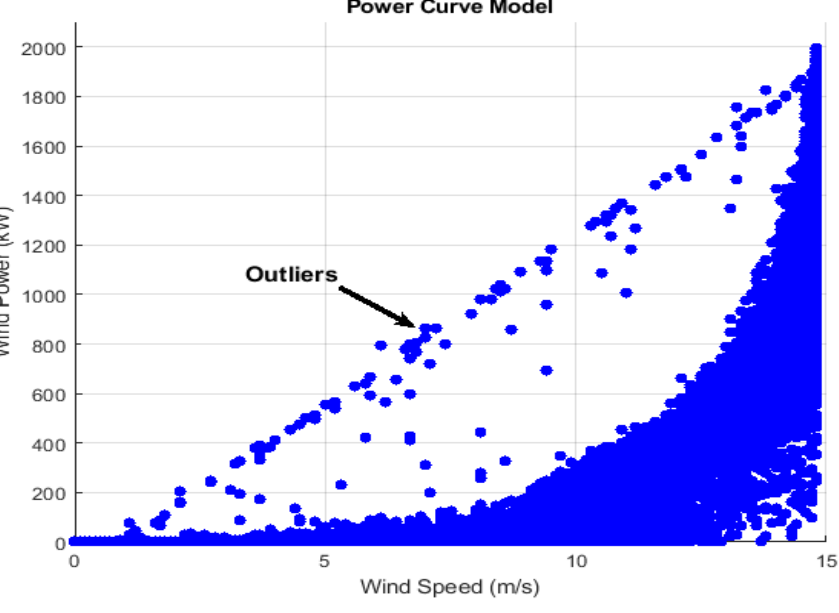
Figure 5. The power curve model of the WT1.